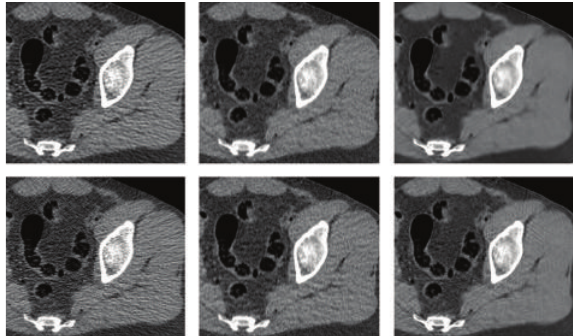
Figure 16: Upper row, left to right: reconstructions optimized for SNR values—FBP (28.5 dB), PWLS (30.6 dB), our method (31.41dB). Lower row: reconstruction with higher spatial resolution—FBP (26.5dB), PWLS (29.6dB), our method (30.73 dB).